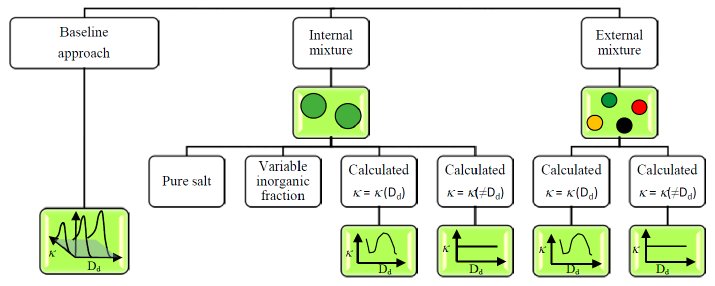
Figure 5. Overview of the N CCN calculation approaches.